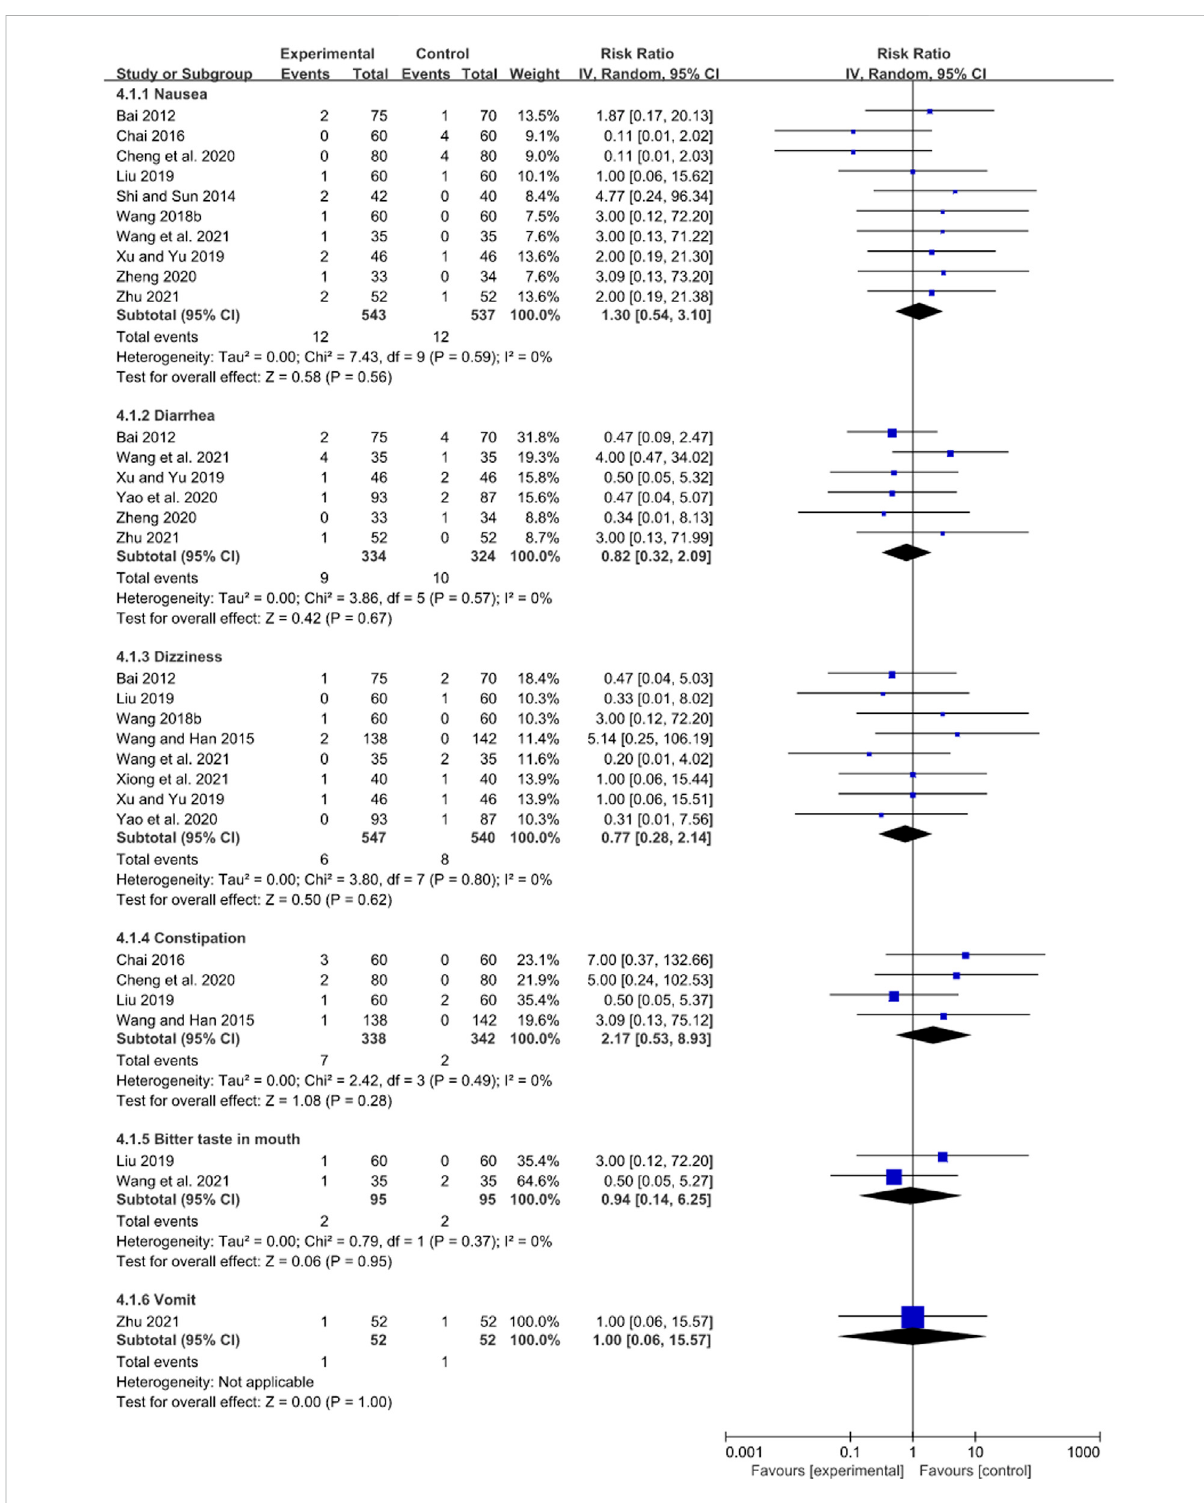
FIGURE 12 Forest plots of adverse